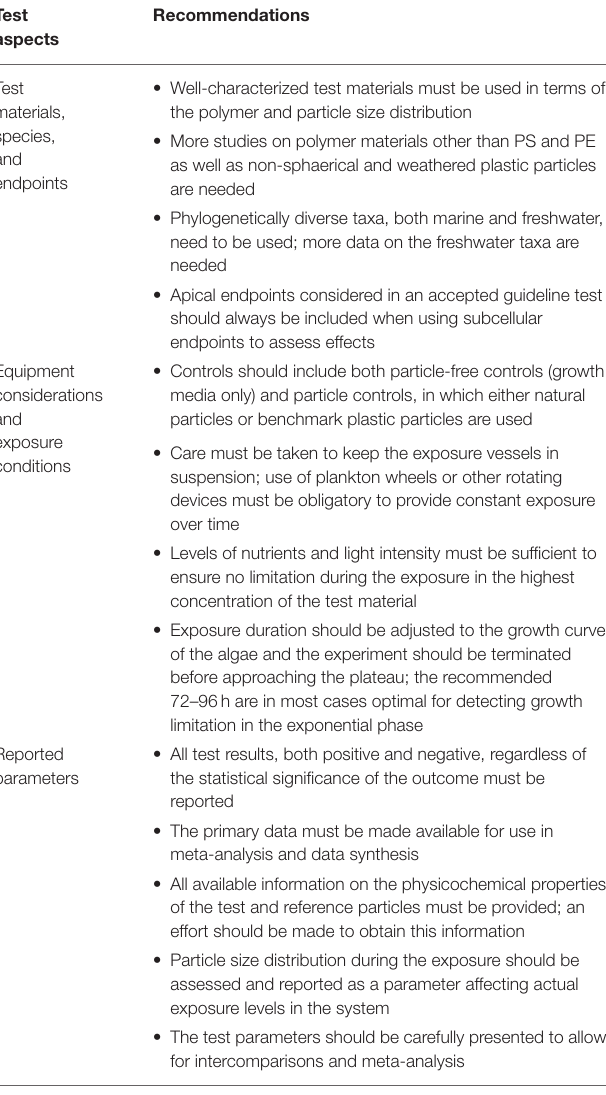
TABLE 2 | Practical recommendations for standardization of algal bioassays with micro- and nanoplastic and reporting routines based on the outcome of the